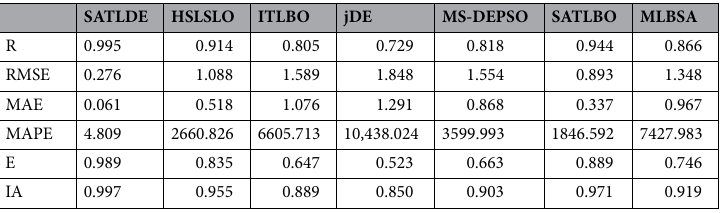
Table 3. Performance metrics of SATLDE algorithm and six other optimizers for ten-reservoir problem.